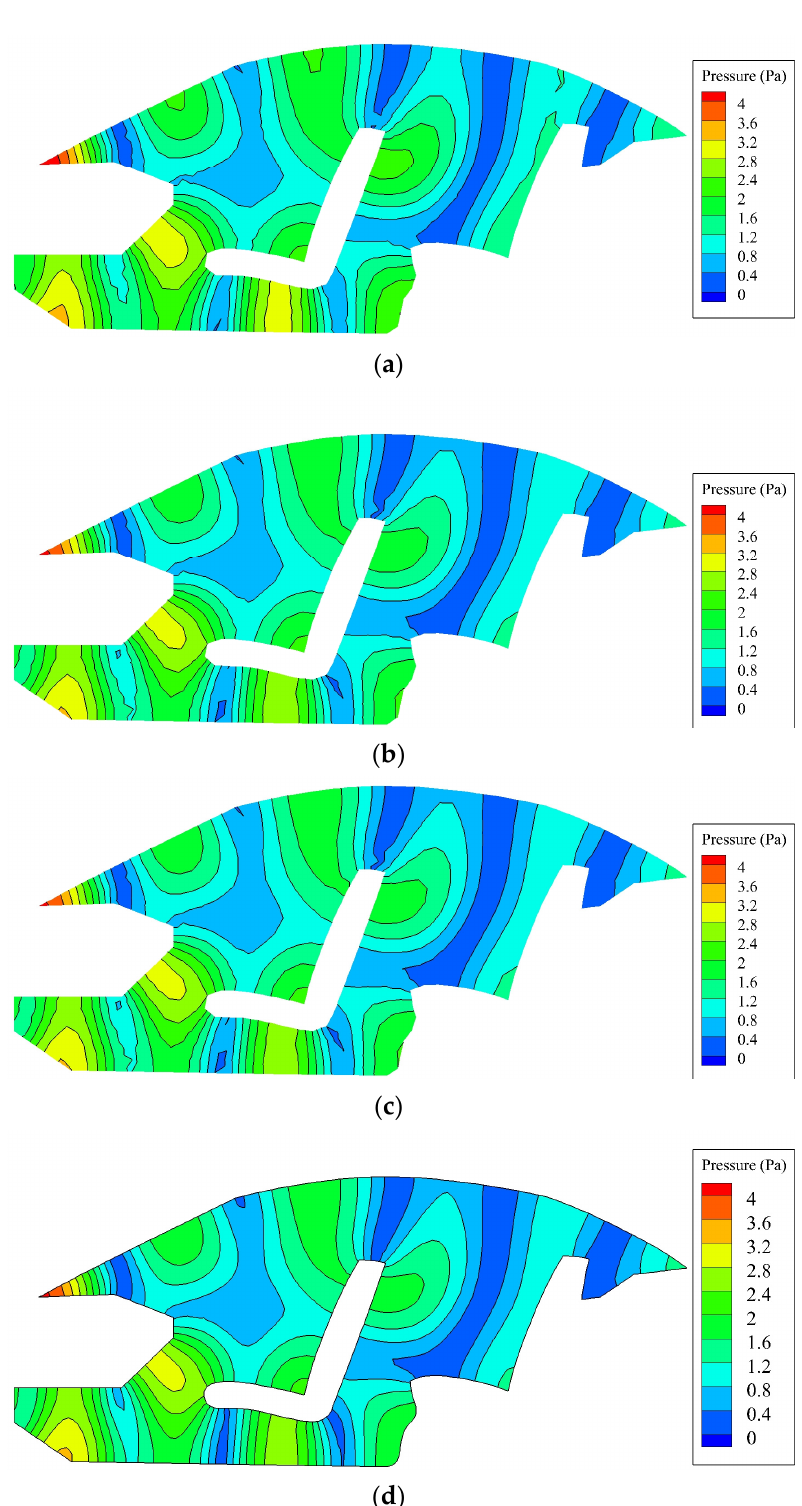
Figure 14. Comparisons the calculated acoustic pressure distribution results from different methods in the total problem domain for the frequency value f = 320 Hz: ( a ) FEM-T3; ( b ) EFEM-N9; ( c ) EFEM- N11; ( d ) reference solution.